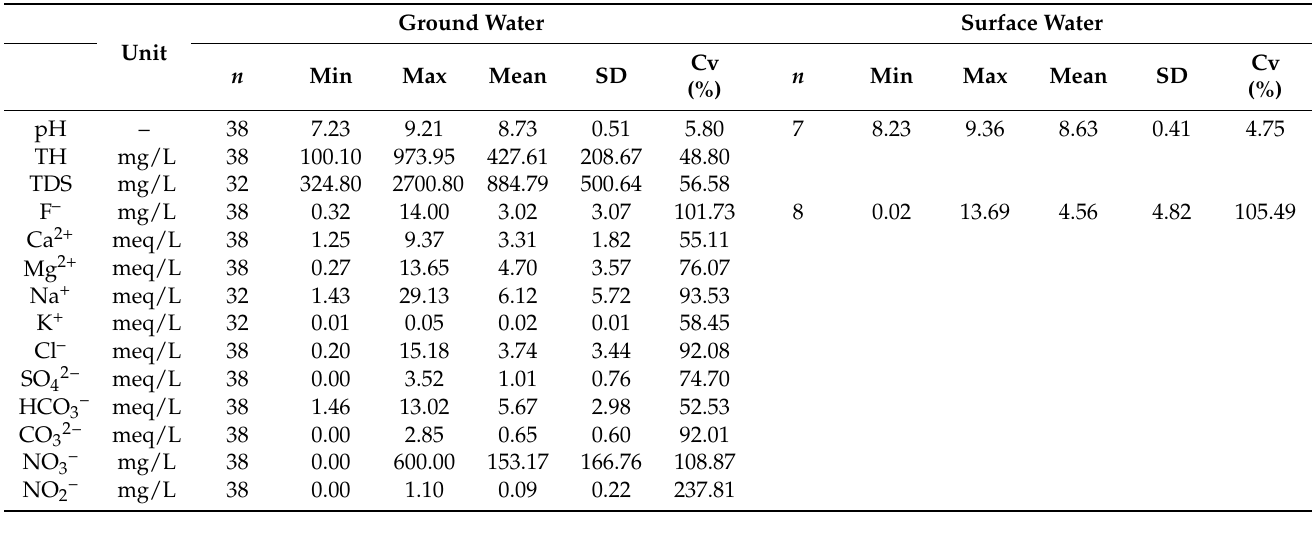
Table 2. Statistical summary of physiochemical parameters in Chagan Lake Catchment. TH, total hardness; TDS, total dissolved solids.